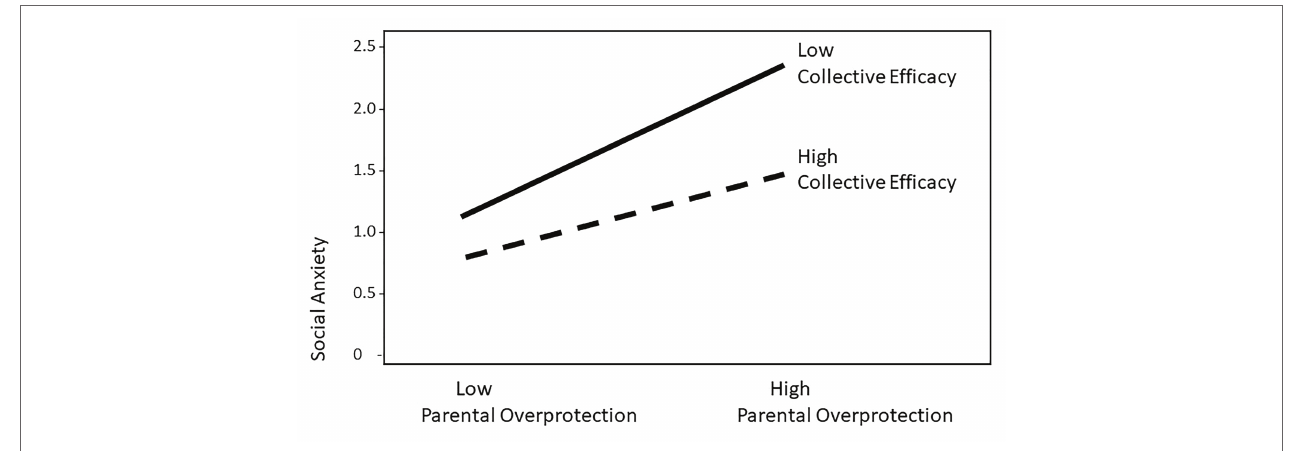
FIGURE 2 | Interaction effect of parental overprotection and collective efficacy. All estimates are standardized